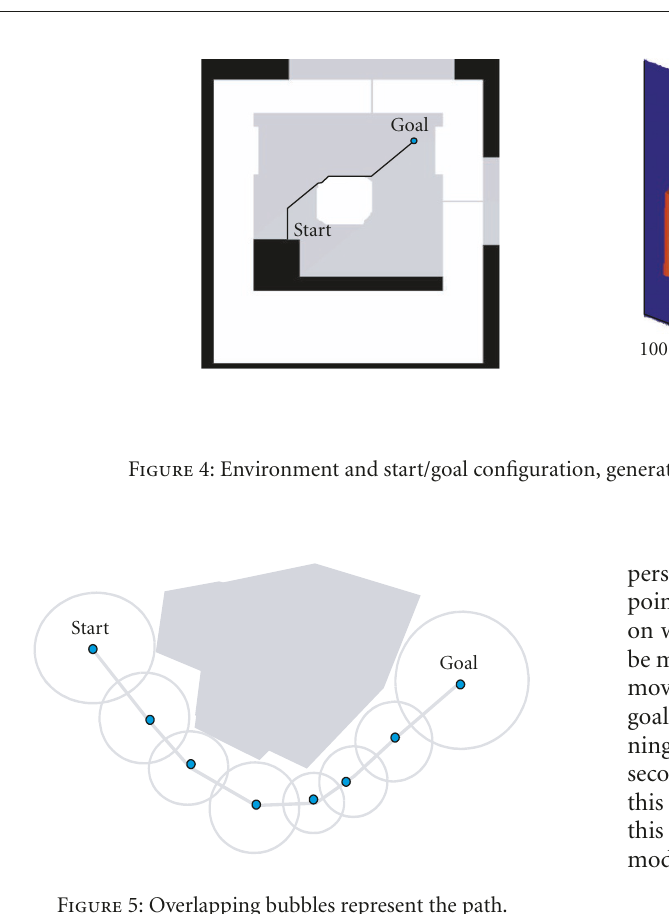
Figure 5: Overlapping bubbles represent the path.